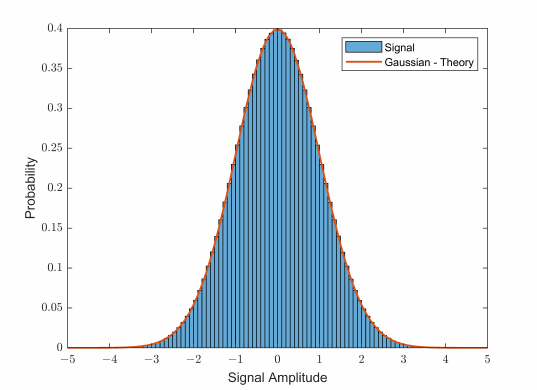
Figure 7. Distribution of the noise-free transmitted GDSS